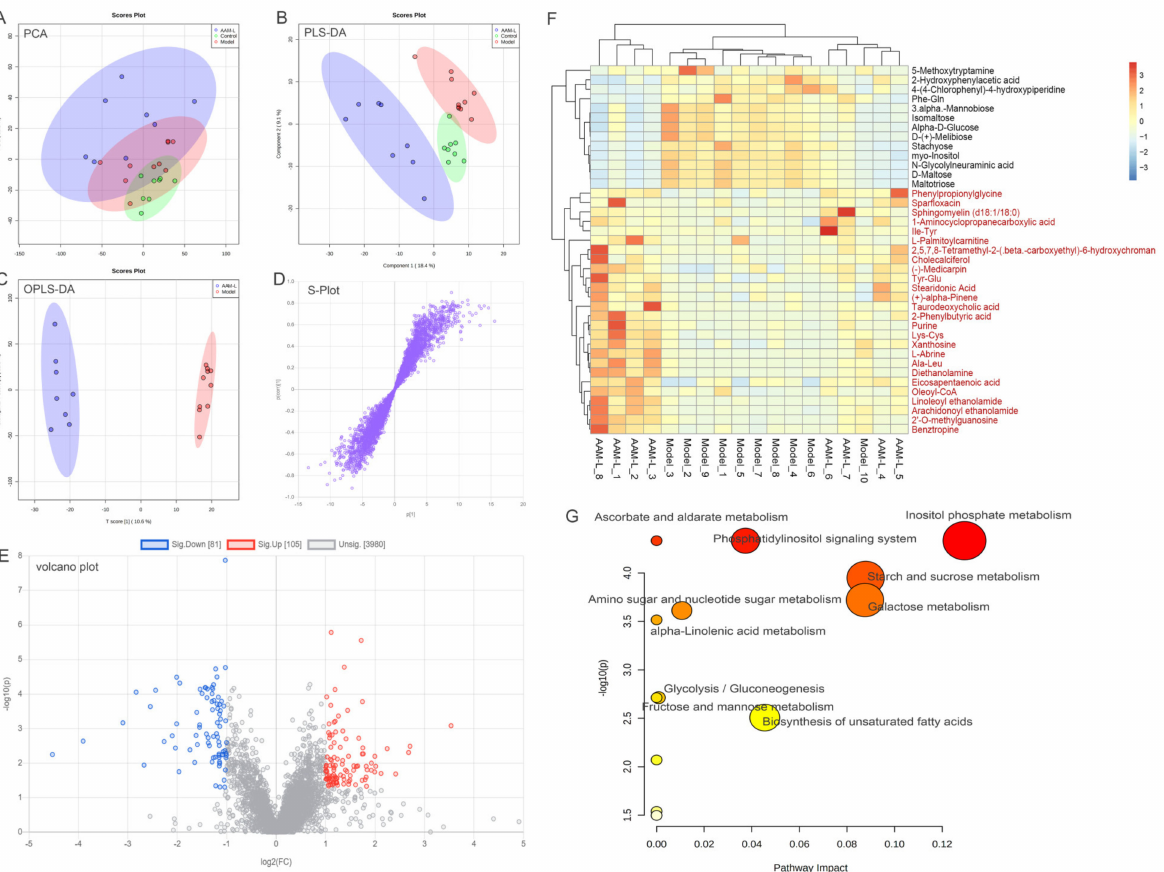
Figure 9. Liver metabolomic profiling by UPLC-QTOF/MS in the positive-ion mode (ESI+). ( A ) PCA score plot for the Control, Model and AAM-L groups; ( B ) PLS-DA score plot for the Control, Model and AAM-L groups; ( C ) OPLS-DA score plot for the AAM-L and Model groups; ( D ) S-loading plot based on the OPLS-DA analysis model of the Control and AAM-L groups; ( E ) Volcano plot of significantly different metabolites in liver ( p < 0.05 and fold change > 2) between the Model and AAM-L groups; ( F ) Heatmap of the relative abundance of significantly different metabolites (VIP value > 1.0, p < 0.05 and fold change > 2) between the Model and AAM-L groups; ( G ) Metabolic pathway impact prediction based on the KEGG online database. The -ln( p ) values from the pathway enrichment analysis are indicated on the horizontal axis, and the impact values are indicated on the vertical